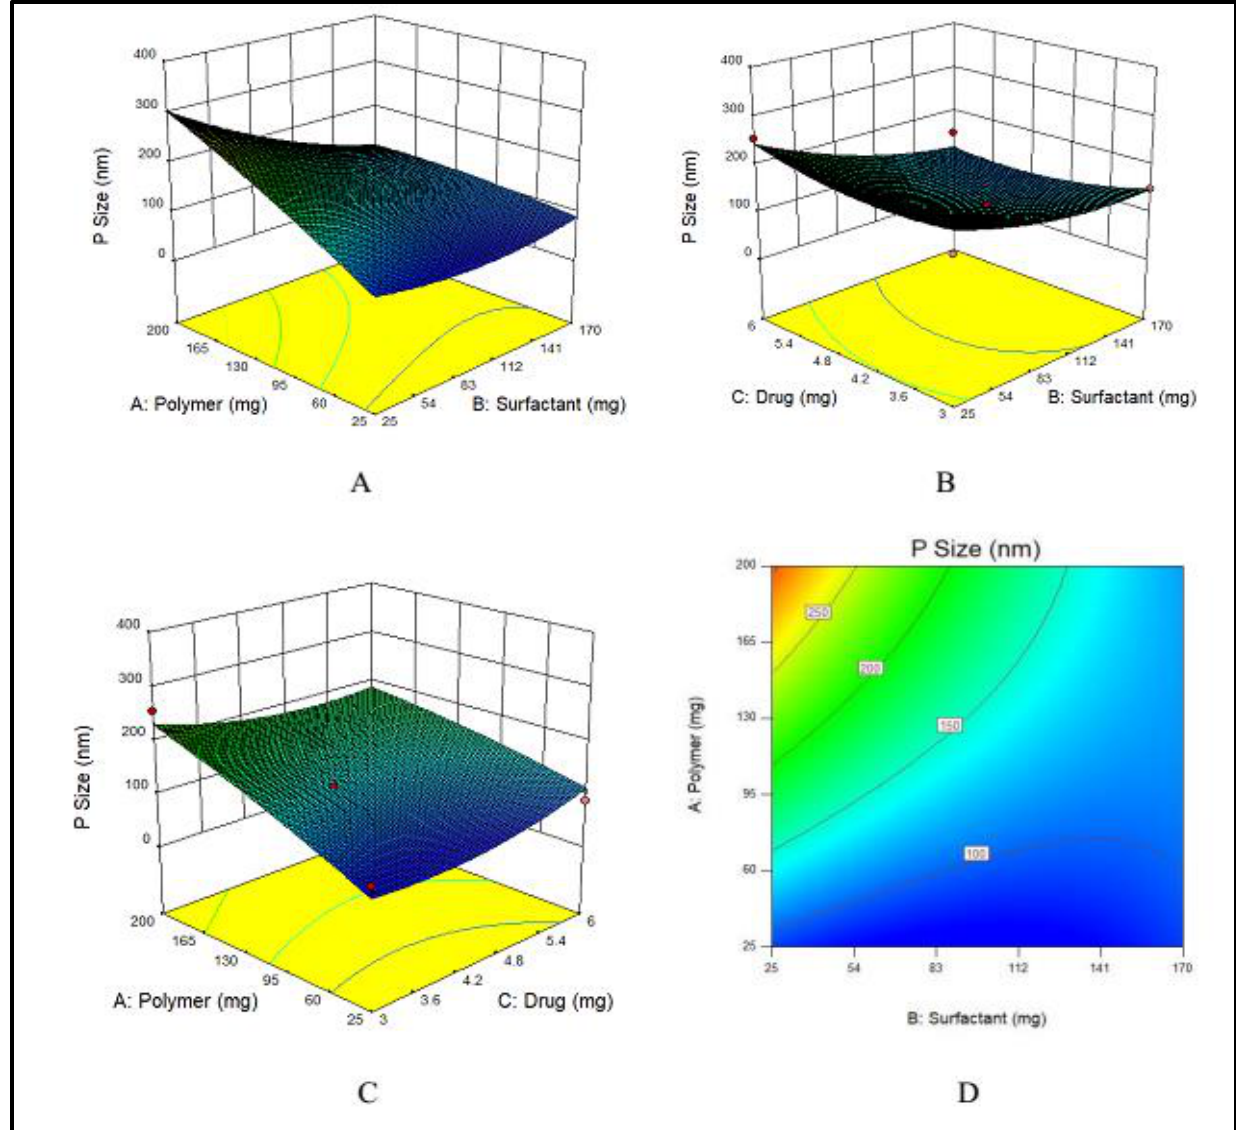
Figure 2. ( A ), ( B ) and ( C ) showing 3D surface plot for impact of PVA (surfactant), E100 (Polymer) and MTX (drug) on particle size of MTX - NPs, respectively while ( D ) showing the combined effects of PVA, E100 and on particle size.